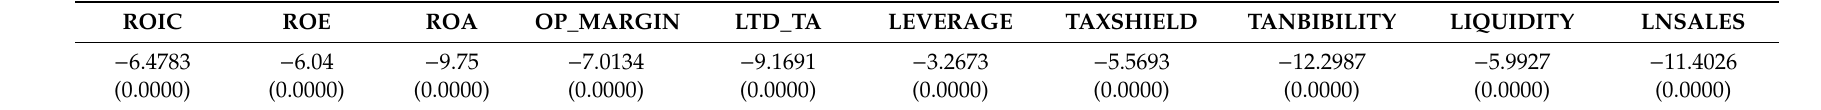
Table 3. Unit root tests